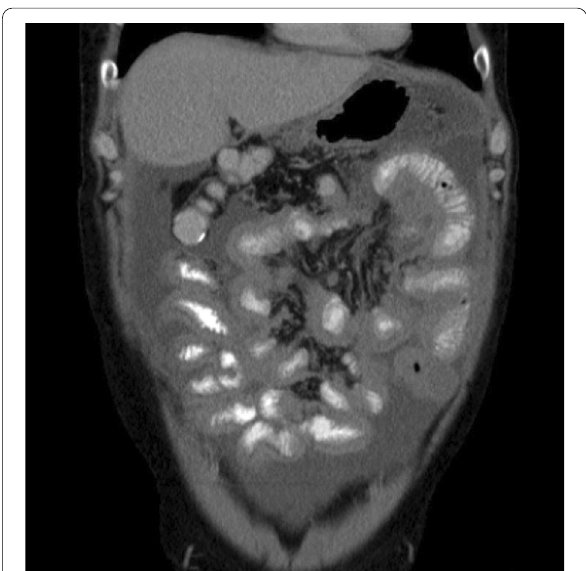
Fig. 15 CT scan, coronal image of a patient with advanced epithelioid malignant peritoneal mesothelioma showing a rind of soft tissue around the small bowel due to diffuse thickening of the small bowel serosa or the visceral